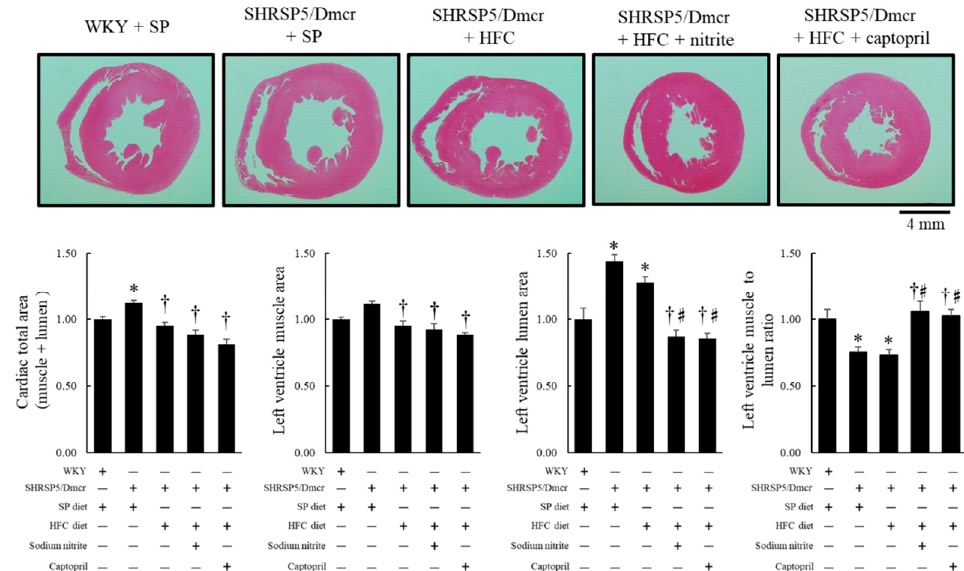
Figure 7. Gross photograph of midventricular short-axis section and quantitative analysis of left ventricular muscle area and chamber size following treatment with nitrite and captopril. Values represent mean ± SE ( n = 6), * p < 0.05 vs. WKY + SP diet group, † p < 0.05 vs. SHRSP5/Dmcr + SP diet group, ♯ p < 0.05 vs. SHRSP5/Dmcr + HFC diet group.